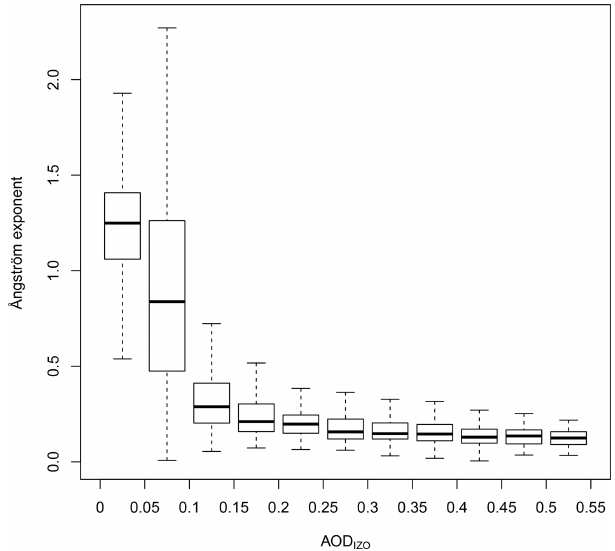
Figure 3. Ångström exponent against AOD measured at Izaña be- tween January 2007 and December 2017. AODs above 0.55 are very scarce and therefore are not shown in the